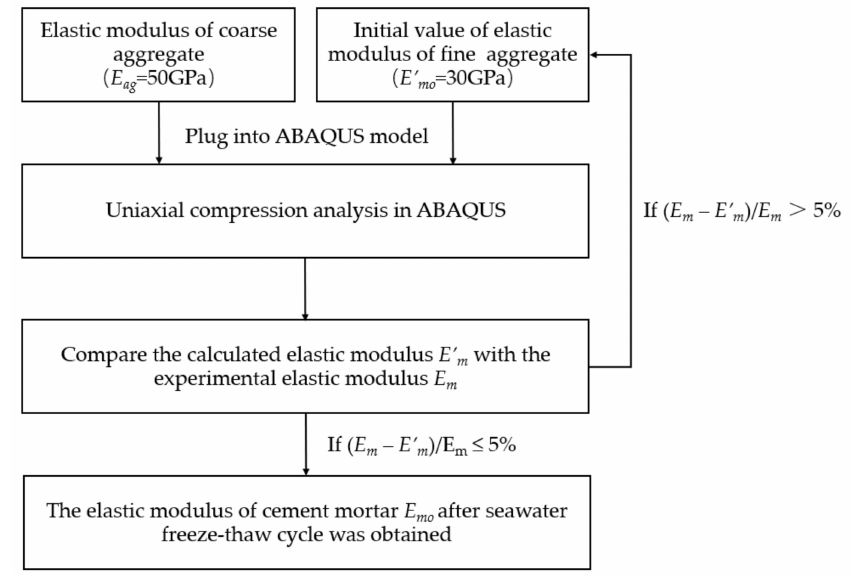
Figure 14. Analysis procedure for the elastic modulus values of cement mortar